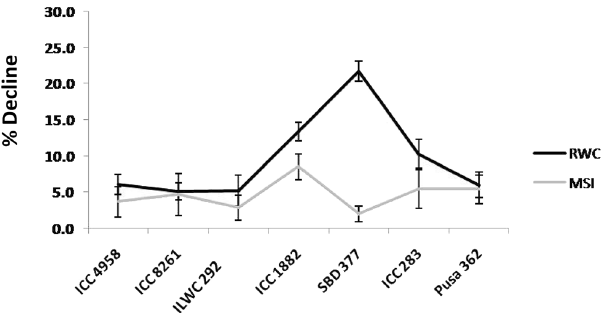
Figure 10. The percentage (%) reduction in leaf relative water content (RWC) and membrane stability index (MSI) of the drought stress treated plants (T24) over the control (C24) or well-watered plants for seven different genotypes, namely ICC 4958, ICC 8261, ILWC 292, ICC 1882, SBD 377, ICC 283 and Pusa 362. ILWC 292 belongs to the wild species C. reticulatum , while the remaining six genotypes belong to the cultivated chickpea species, C. arietinum . ICC 4958, ICC 8261, ILWC 292, Pusa 362 are drought tolerant and ICC 1882, SBD 377 and ICC 283 are drought sensitive. Data for RWC and MSI were recorded for the C24 and T24 plants on 117 DAS. An average value of five biological replicates/genotype/treatment (n = 5) were used for both the traits, to plot the line graphs. Vertical lines represent the mean ±